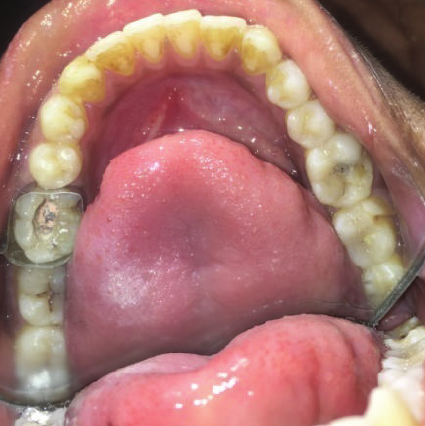
Figure 22: Photograph showing inlay luted with respect to 37 (occlusal view).